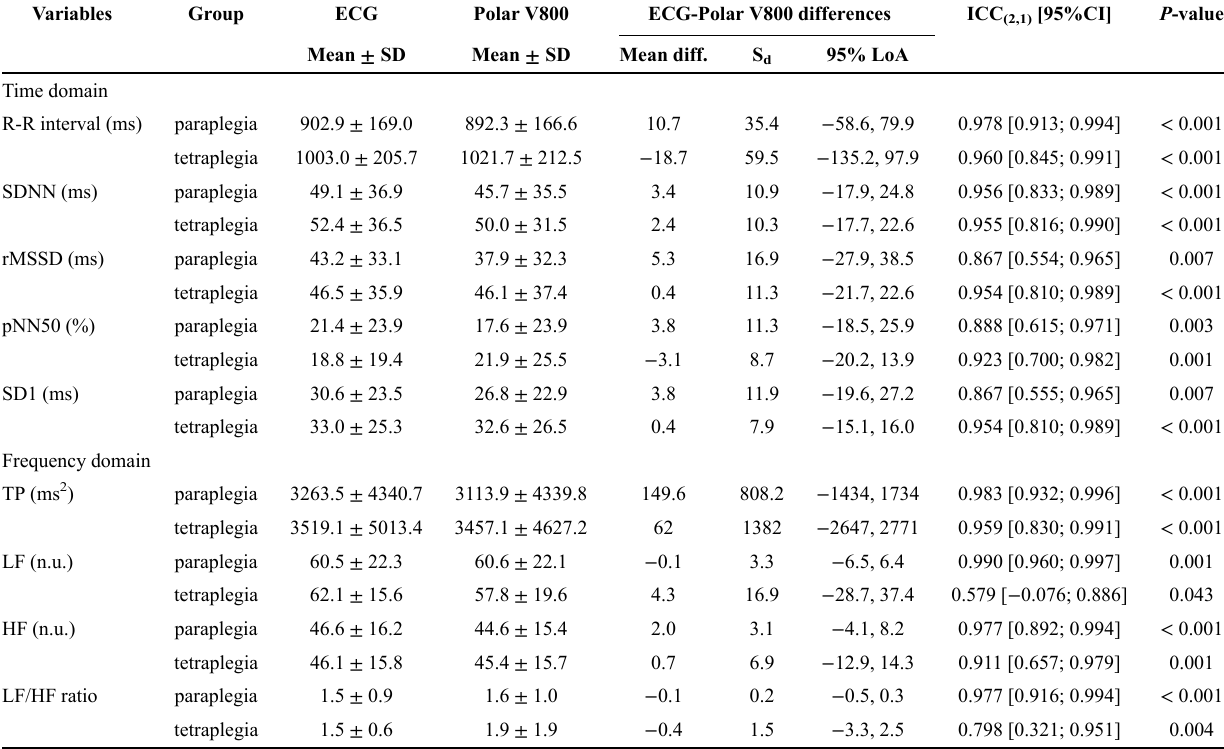
Table 2 - Mean ± SD values for resting heart rate variability indices derived from ECG vs . Polar V800 in paraplegia (n = 10) and tetraplegia (n = 9) groups.